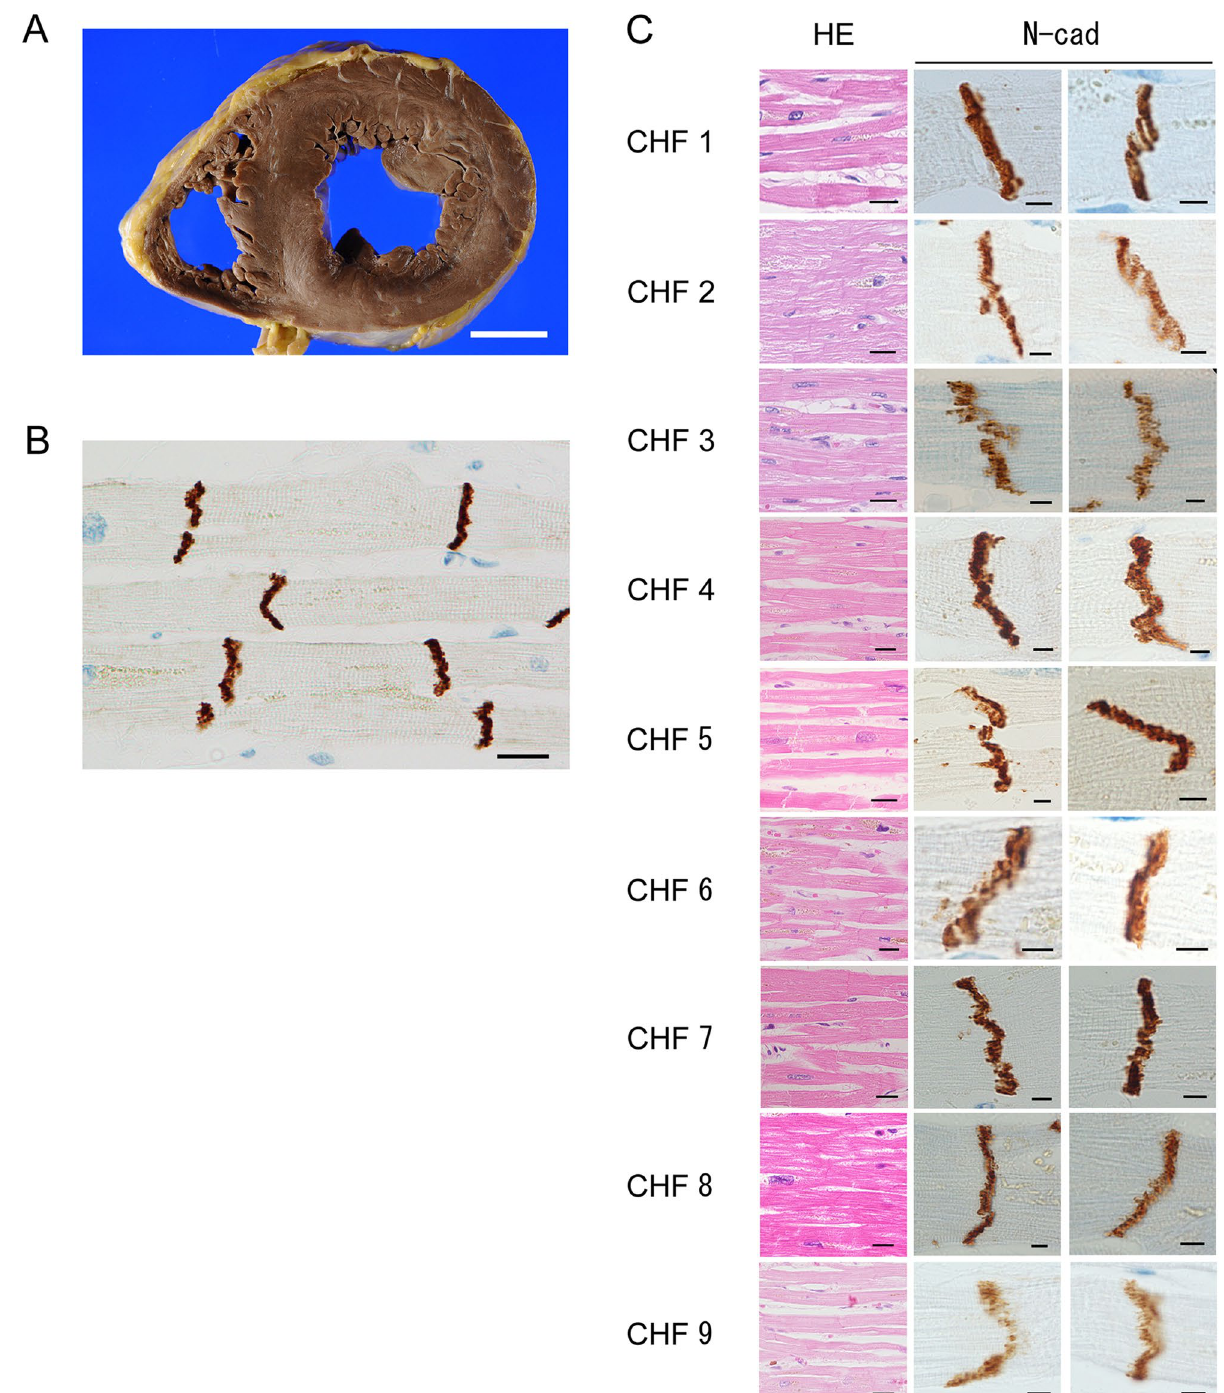
Figure 3. Pathological and immunohistochemical findings in cases of chronic heart failure. ( A ) Macroscopically, we observed mild-to-moderate dilation of the bilateral ventricles. The LV wall was thinner than in the control group. Depending on the cause of CHF, such as acute myocardial infarction, thickness was sometimes uneven. ( B ) ICDs could be seen relatively clearly, and the units of cardiomyocytes were clear. (N-cadherin immunostaining; scale bar, 20 µm; original magnification, × 400). The width of the ICDs was slightly wider in the CHF group than in the control group. ( C ) Histologically, ICDs were observed between cardiomyocytes, but their structures were somewhat irregular and hard to see (H-E staining; scale bar, 20 µm; original magnification, × 400). Immunohistochemistry for N-cadherin revealed that the width of the ICDs was approximately two to six sarcomeres, and was wider than in the control group (N-cadherin immunostaining; scale bar, 5 µm; original magnification, × 1000). The ICDs had a stepwise appearance and were